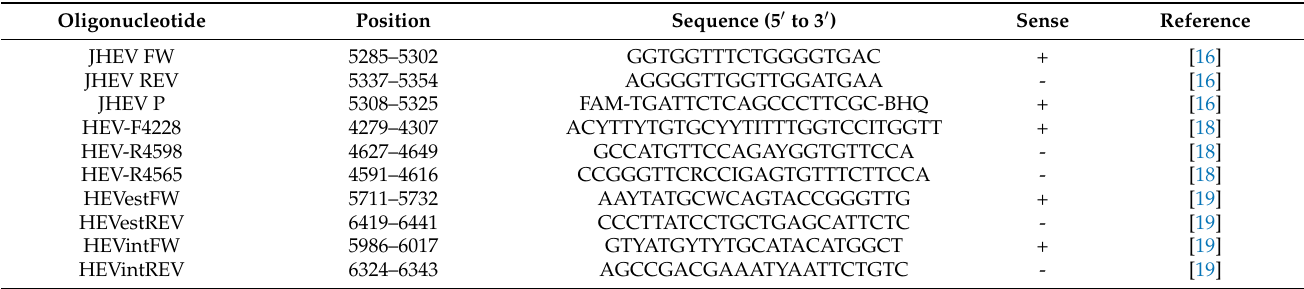
Table 1. List of primers used in this study. Nucleotide position refers to the sequence of the strain HEV/SwGt3/Meng (GenBank accession no. AF082843).